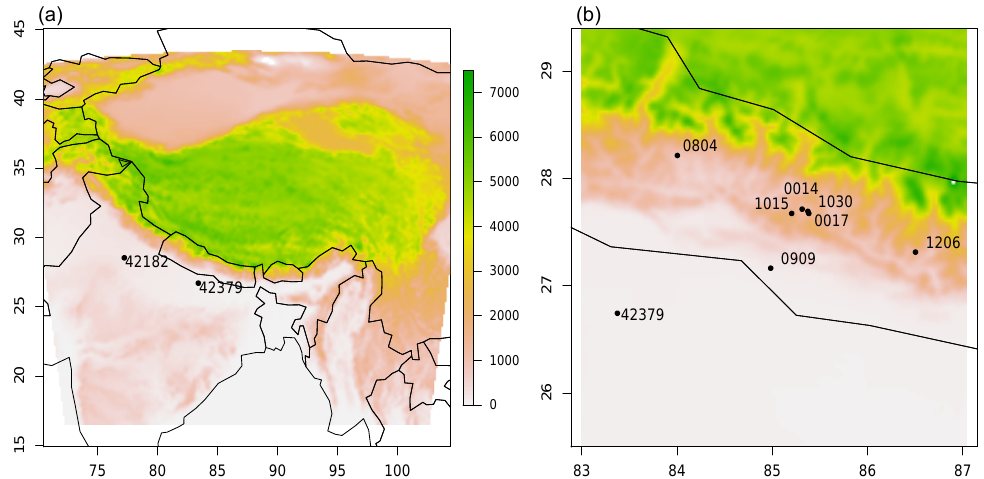
Figure 1. Model domains D01 (a) and D02 (b) as used in the WRF and WRF-Chem simulations. Shown are the terrain heights (m) and the locations and station numbers of the measurement